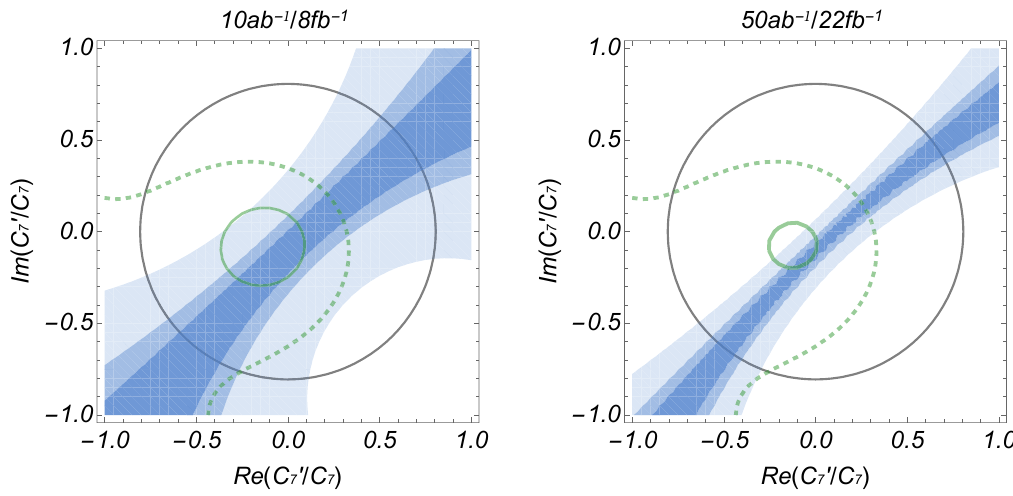
Figure 5 . Prospects for constraining, at the three standard-deviations level, Re ( C Im ( C ) from a measurement of , integrating over the whole Dalitz plane. The colour (cid:31) 7 /C 7 S π + π − K 0 S γ changes from dark blue to light blue for decreasing values of the dilution factor is chosen arbitrarily to be, respectively, For each of these, a central value of S π + π − K 0 S γ 0 . 15 , 0 . 09 , 0 . 05 , and the current experimental uncertainty is scaled by the increase of integrated { } luminosity. The grey and green contours are described in figure